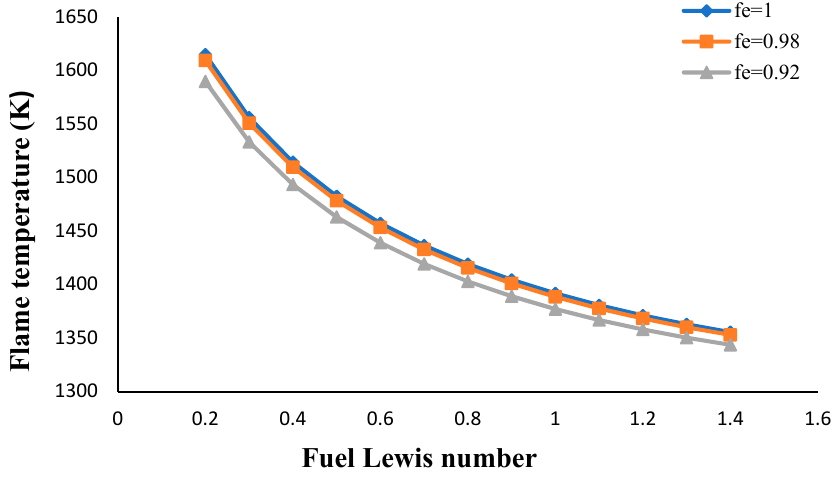
Figure 4. Flame temperature against the fuel Lewis number for several porosity factors.